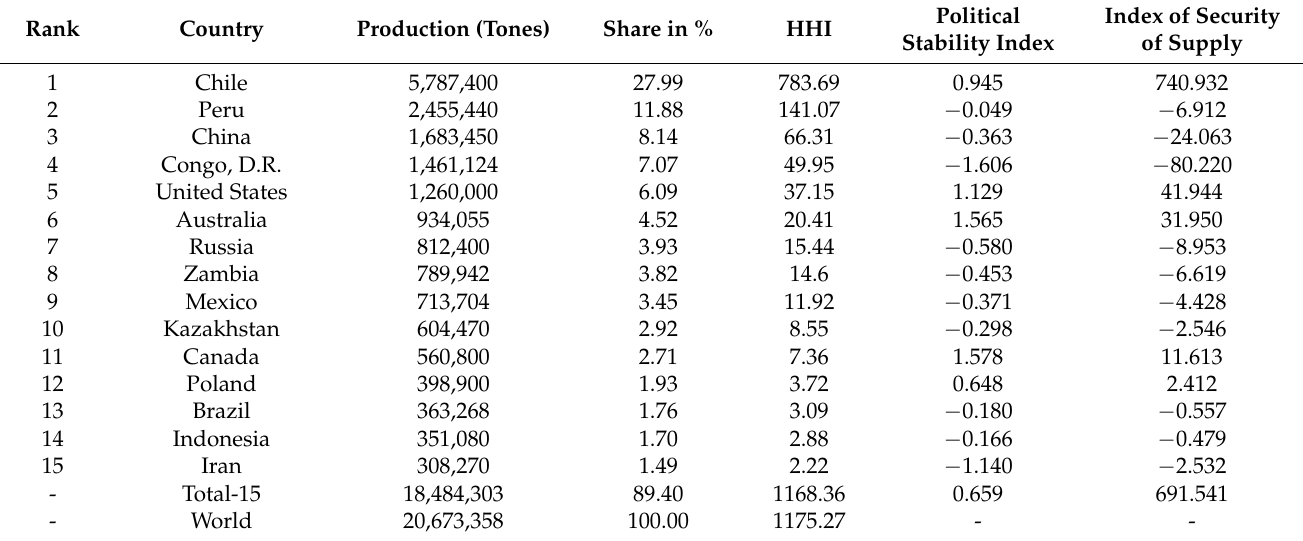
Table 2. Herfindahl-Hirschman index, index of security of supply and copper production in 2020.